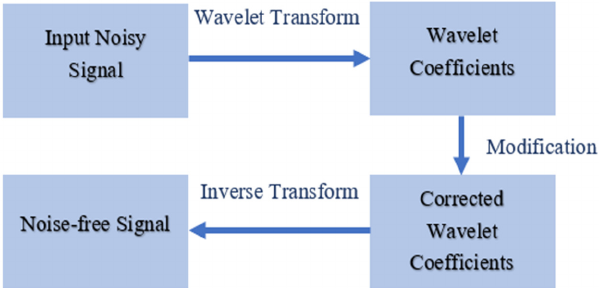
Figure 1. Basic flow chart of wavelet-based signal denoising.